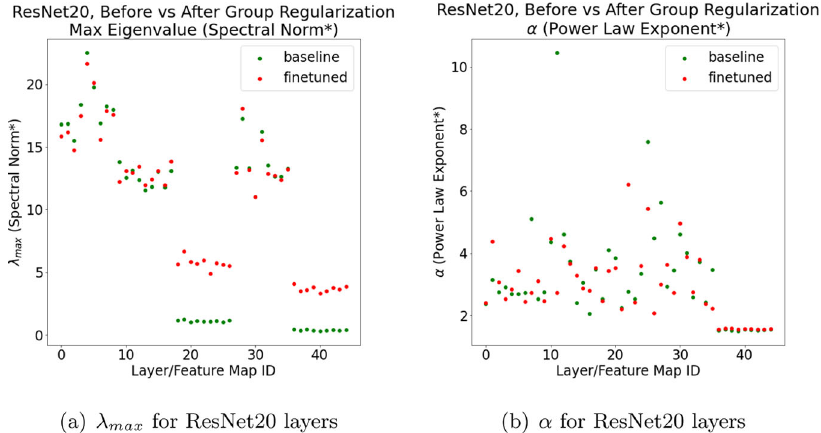
Fig. 5 ResNet20, distilled with Group Regularization, as implemented in the distiller (4D_regularized_5Lremoved) pretrained models. Log Spectral Norm ( log λ max , in ( a )) and PL exponent ( α , in ( b )) for individual layers, versus layer id, for both baseline (before distillation, green) and fi ne-tuned (after distillation, red) pretrained